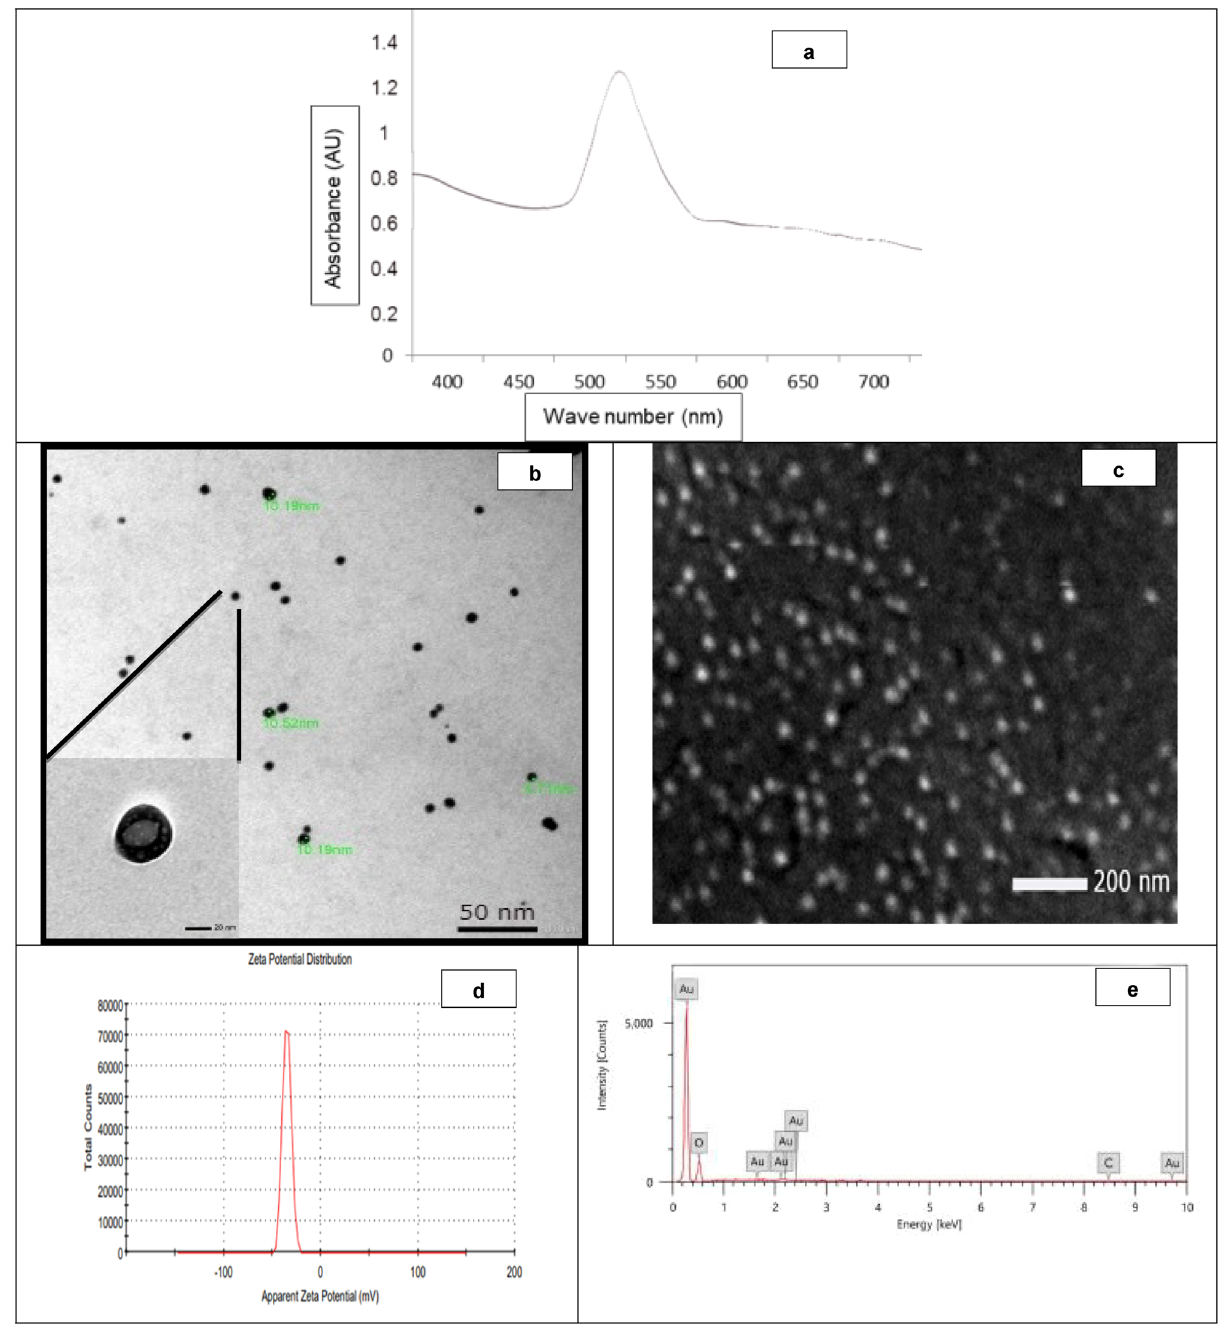
Figure 1. Au-NPs physicochemical characteristics; where ( a ) UV–Vis spectrum, ( b ) TEM analysis, ( c ) SEM analysis, ( d ) Zeta potential, ( e ) EDX, ( f ) FTIR analysis and ( g ) X-ray diffraction of the prepared